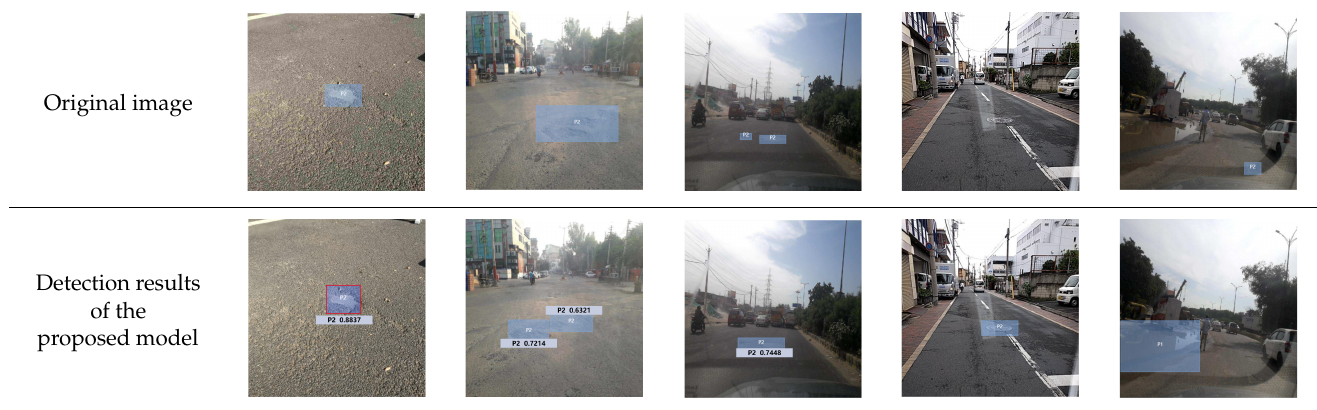
Table 11. Detection examples of the open-source dataset using the proposed model.